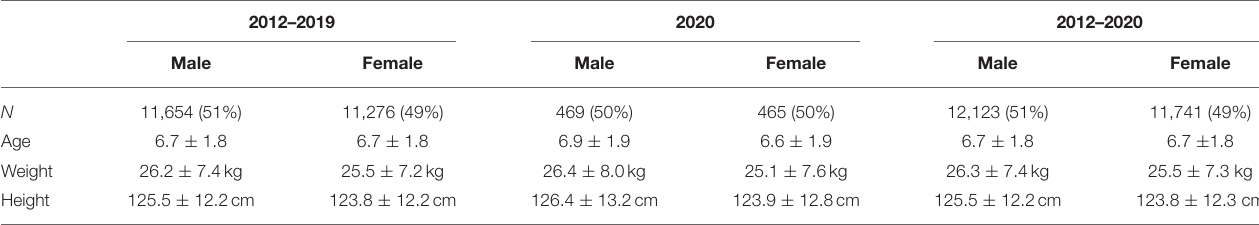
TABLE 2 | Sample description (means ±